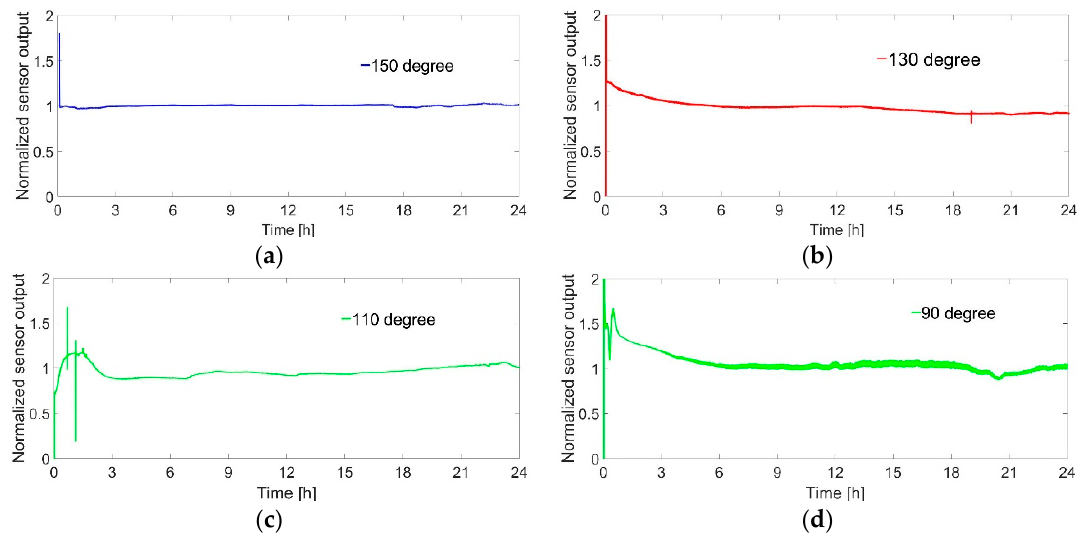
Figure 12. Normalized sensor output for 24 h in continuous hydrogen flow of 1.5% at operating temperature of ( a ) 150 °C; ( b ) 130 °C; ( c ) 110 °C and ( d ) 90 °C; at 150 °C, 130 °C and 110 °C stable temperature of ( a ) 150 ◦ C; ( b ) 130 ◦ C; ( c ) 110 ◦ C and ( d ) 90 ◦ C; at 150 ◦ C, 130 ◦ C and 110 ◦ C stable output, output fluctuates at 90 °C. output, output fluctuates at 90 ◦